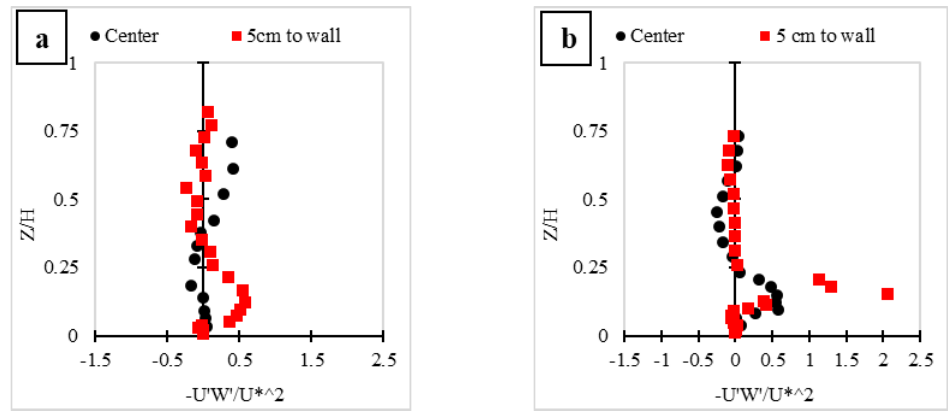
Figure 8. Reynolds stress profiles for: ( a ) the pool area and ( b ) the riffle area in the center and 5 cm from the riverbank.